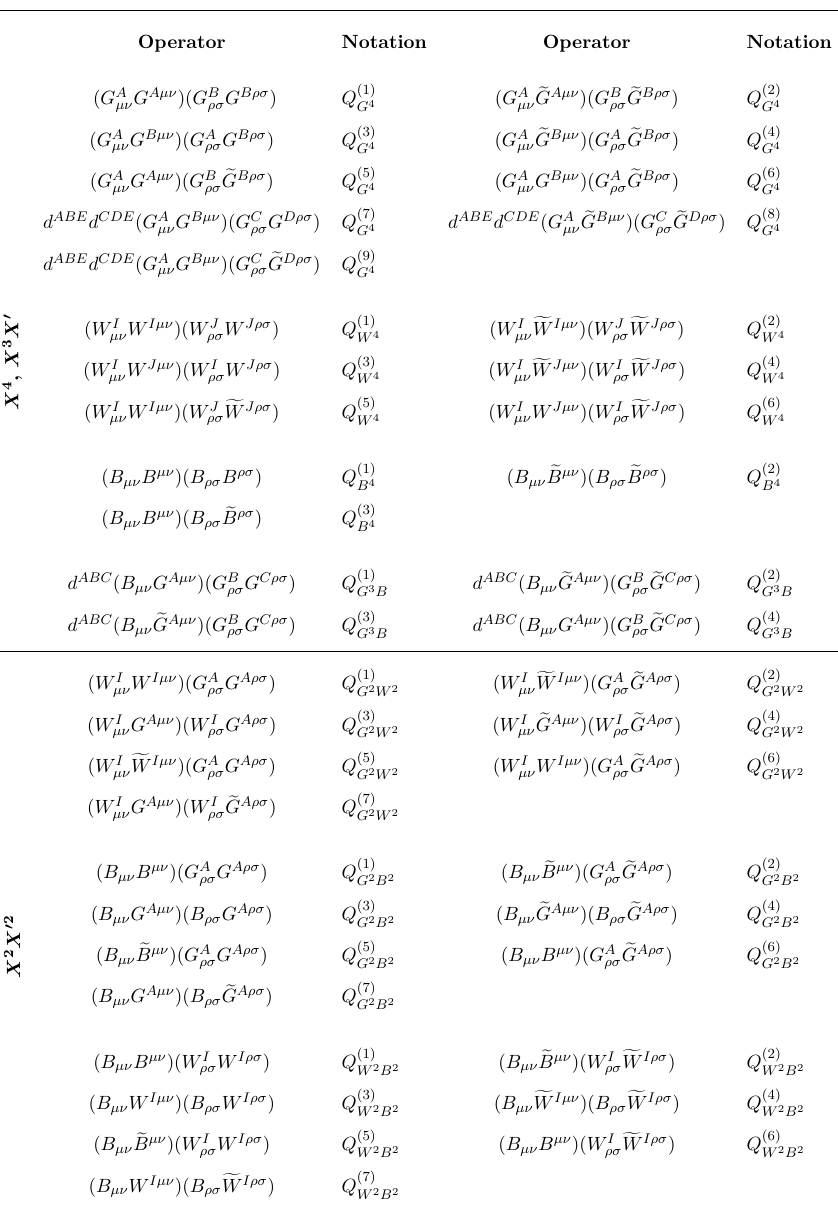
Table 3 . Green’s basis of operators, part